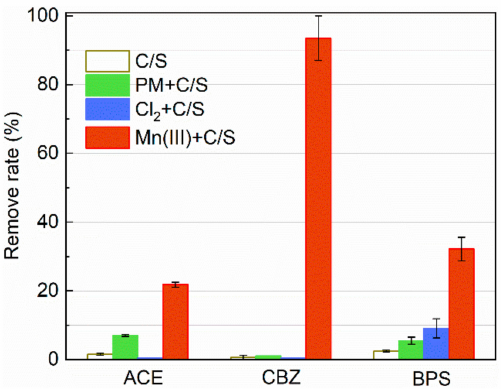
Figure 3. Removal e ffi ciency of emerging micropollutants by C / S and C / S enhanced with Mn(III) pre-oxidation, KMnO 4 pre-oxidation, and chlorine